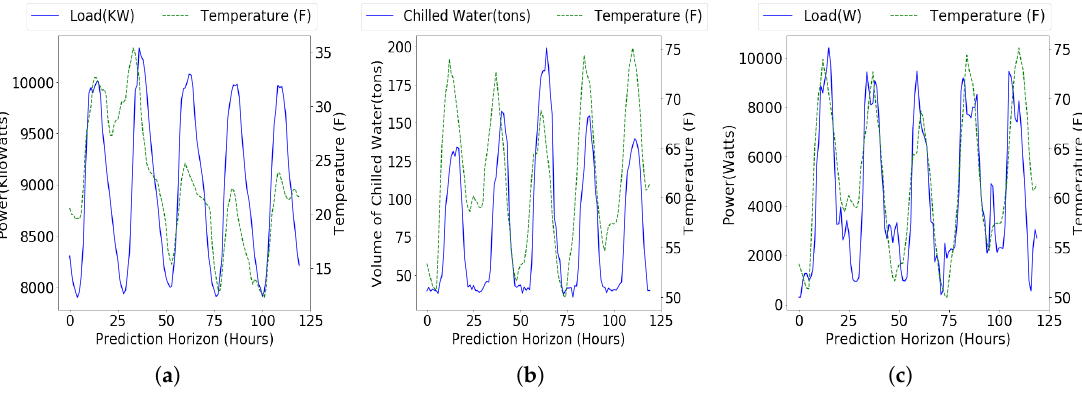
Figure 1. Different 5-day loads and temperatures. ( a ) Aggregate Electricity Load and Temperature of Carnegie Mellon University; ( b ) Cooling load and Temperature for Y2E2 building in Stanford Campus; ( c ) Lighting load and Temperature for Y2E2 building in Stanford